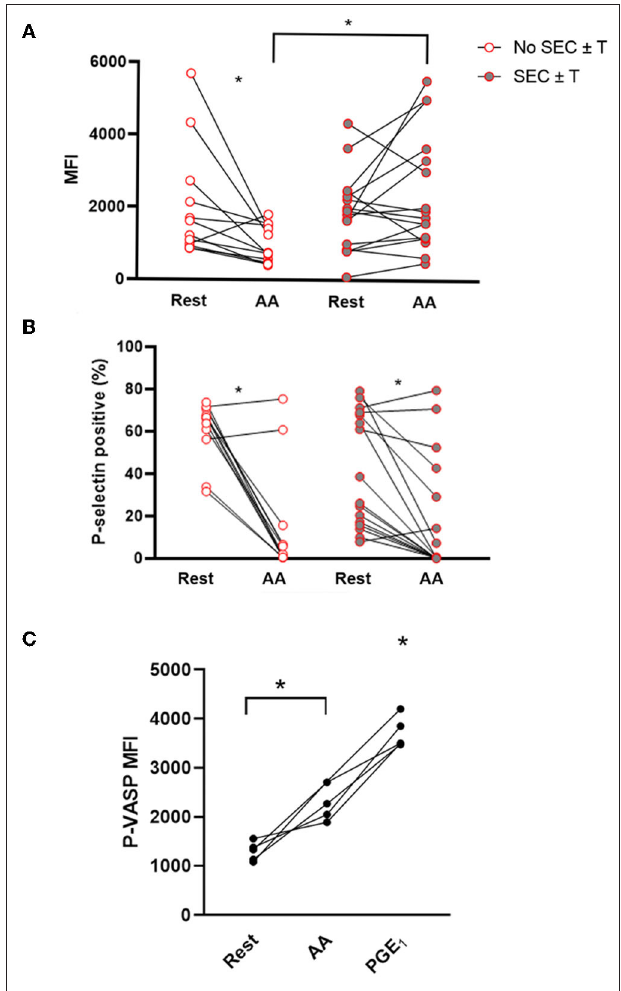
FIGURE 5 | Ex vivo treatment of platelets with arachidonic acid results in platelet inhibition but not in those with spontaneous echocardiographic contrast with or without intracardiac thrombi. Platelet activation was assessed in 29 cats with wildfire (WF) injuries, measured as P-selectin median fluorescence intensity (MFI) (A) or percentage (%) of P-selectin positive platelets (B) at rest and in the presence of 1 µ M arachidonic acid (AA) by flow cytometry. While AA caused a significant decrease in percentage of P-selectin positive platelets in cats with or without SEC ± T (A) , those with SEC ± T sustained P-selectin density (MFI) following AA treatment compared to those without SEC ± T, which had significantly lower MFI (B) . (C) Platelets from five healthy cats were unstimulated (rest) or treated with either 1 µ M AA or 10 µ M PGE 1 . Phosphorylation of intracellular vasodilator-stimulated phosphoprotein (P-VASP) was measured by flow cytometry. Elevation in P-VASP MFI in the presence of AA indicates significant platelet inhibition. * p <